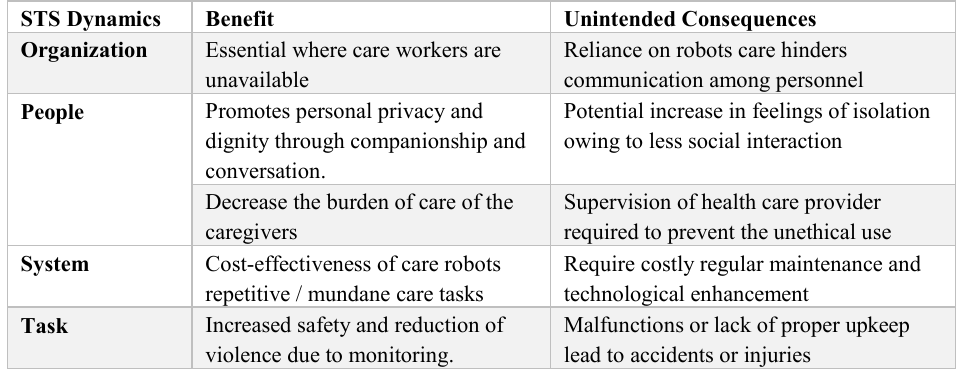
Table 2: Unintended Consequences of Care Robots – Sociotechnical Perspective (Our review) STS